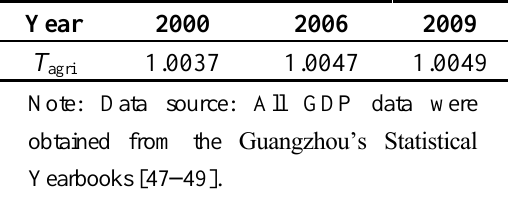
Table 10. Technology contribution coefficient in Guangzhou.